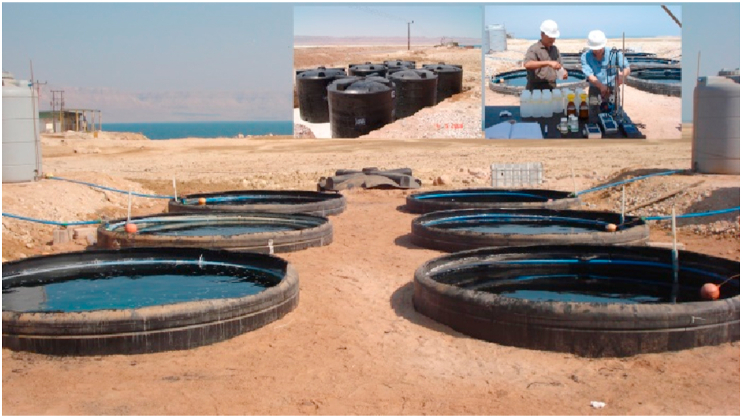
Experimental site.